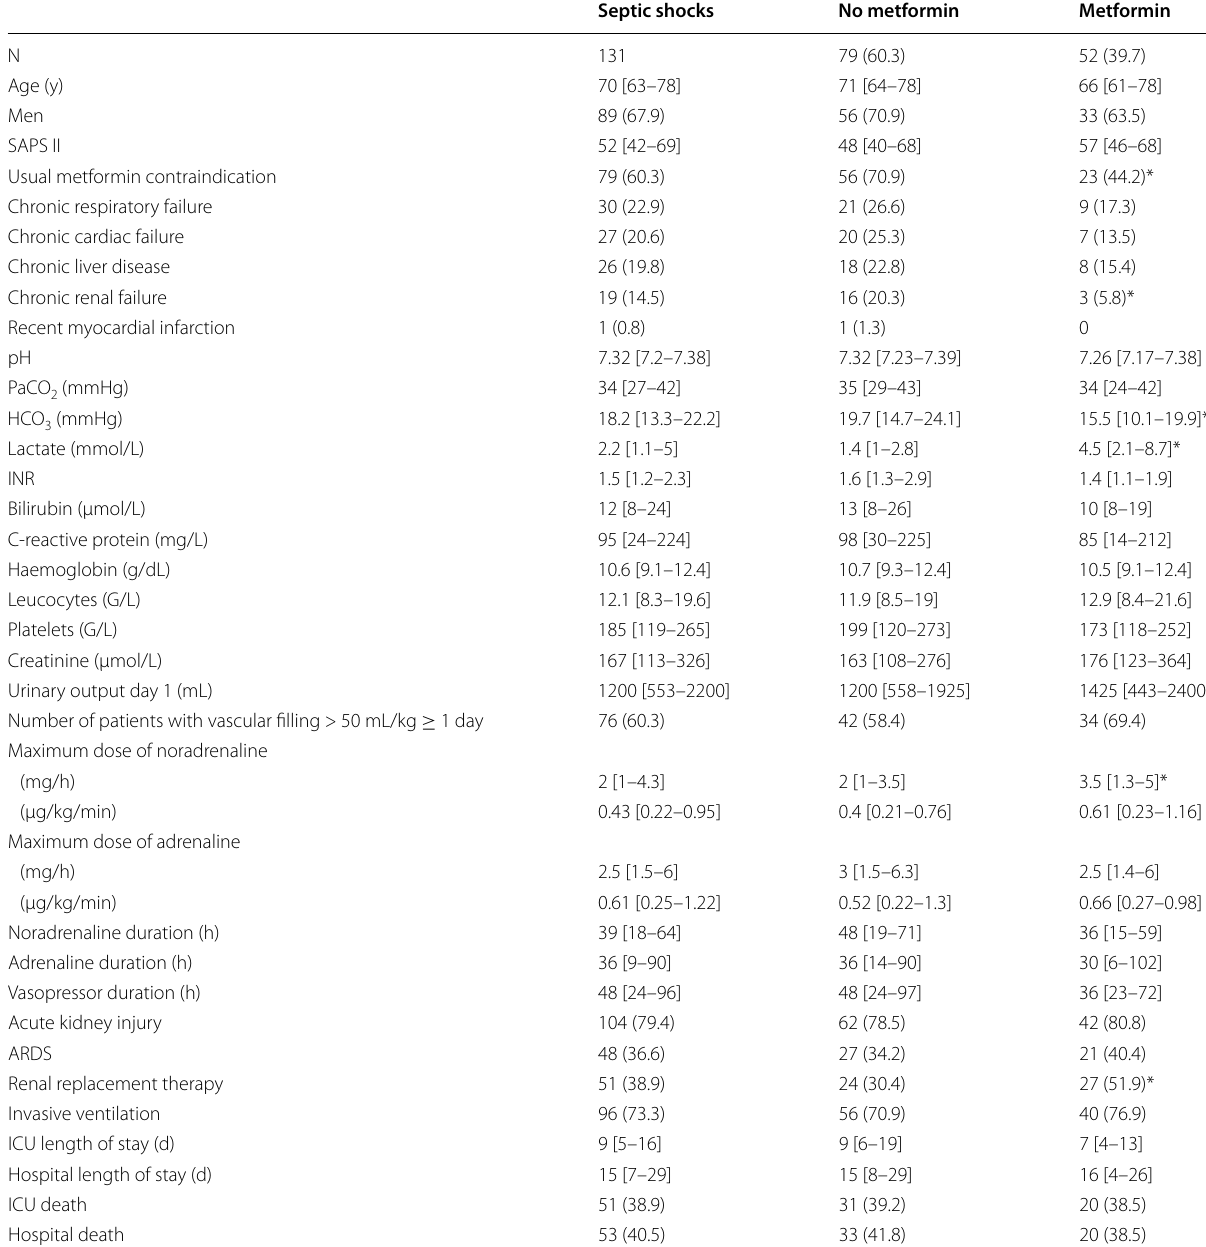
Table 2 Subgroup of ICU diabetics with septic shock: main characteristics at ICU admission, during ICU stay and ICU/hos- pital